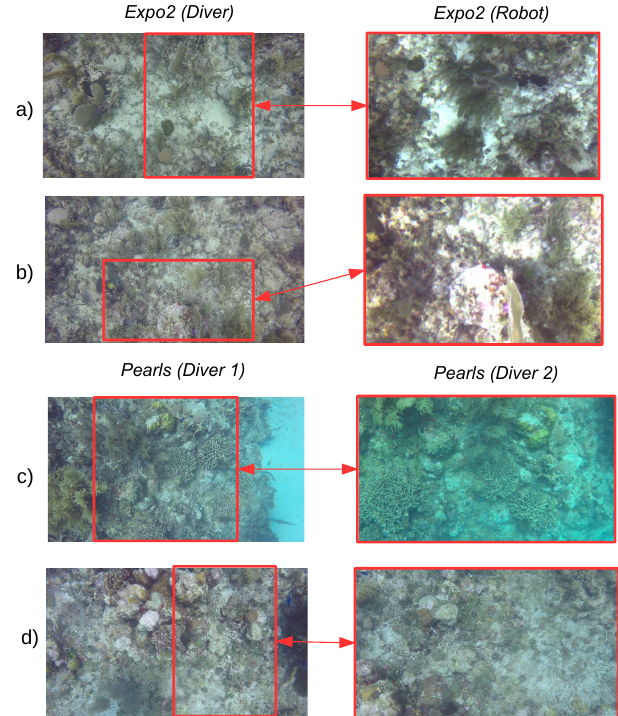
Figure 12. Examples of recognized places from images taken from different agents. ( a ) In this example the image taken by the underwater robot is from the same place than the one taken by a diver but rotated approximately 90 ◦ to the right. ( b ) The same place is captured in both images but the one captured by the robot is closer to the coral reef than the one captured by the diver. Moreover, the image captured by the robot is more illuminated. ( c ) These images were taken from the same place but the one captured by the second diver is closer to the coral reef and rotated approximately 90 ◦ to the left with respect to the one captured by the first diver. In addition to that, the second one is more bluish than the first one. ( d ) In this case the image captured by the second diver is closer to the coral reef and rotated to the approximately 90 ◦ left with respect to the one captured by the first diver.